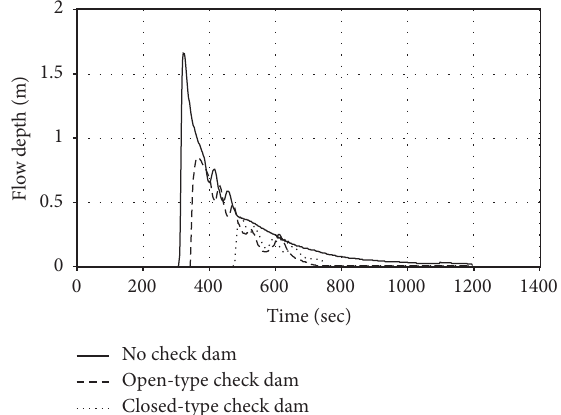
Figure 12: Observation 2 with or without a check dam at the front- end of cover structure and comparison of changes in maximum flow depth between the